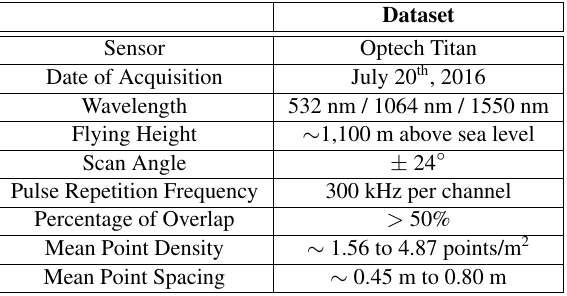
Table 1. LiDAR system settings and data